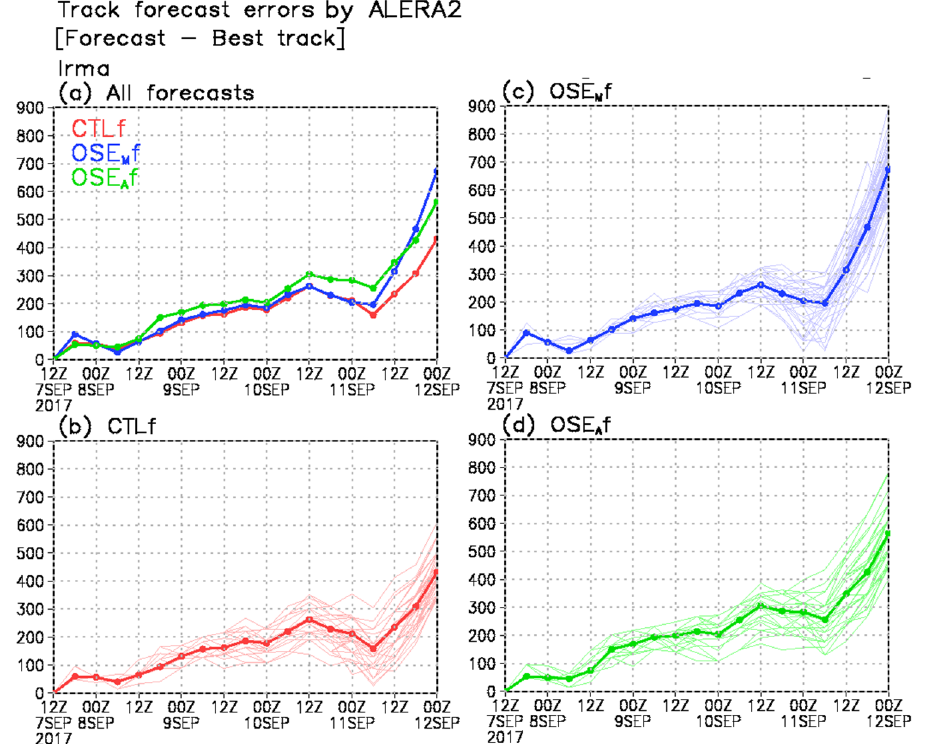
Figure 5. ( a ) Central position error for hurricane Irma between 1200 UTC 7 September 2017 and 0000 UTC 12 September 2017, predicted by CTLf (red), OSE M f (blue), and OSE A f (green). Central position error was calculated as the difference between predicted track and best track for ensemble mean (thick line) and ensemble members (thin lines) from ( b ) CTLf, ( c ) OSE M f, and ( d ) OSE A f. Large errors in predicted upper-level wind speed over the east coast of US cause the predicted tracks of Irma to displace further eastward (Figure 4b,c). The difference between CTLf and OSE M f in